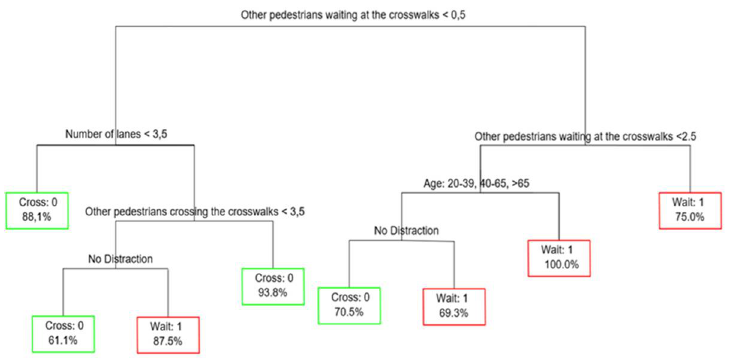
Figure 1. Classification tree results.